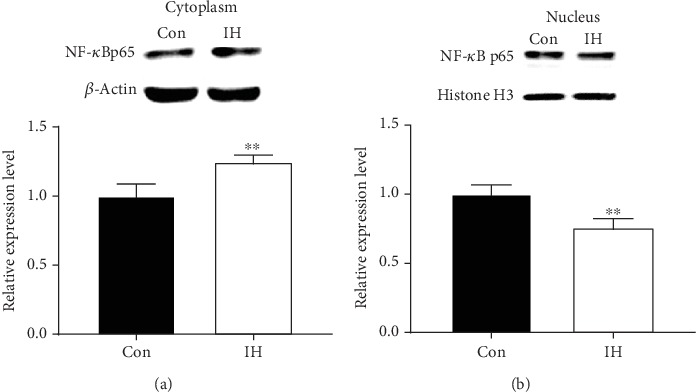
Effect of isorhamnetin on NF-κB in B16F10 cells. Cytosolic extracts and nuclear extracts were prepared after incubated with 100 μmol/L IH for 24 h. (a, b) The translocation of NF-κB p65 was detected by Western blotting. All proteins were determined with specific antibodies. The suppressive effect of IH was confirmed by the upregulation of cytosolic NF-κB and downregulation of nuclear NF-κB. The anti-β-actin antibody and anti-Histone H3 were used to check the proper protein loading. Each experiment was repeated at least three times. ∗p < 0.05 compared with control.